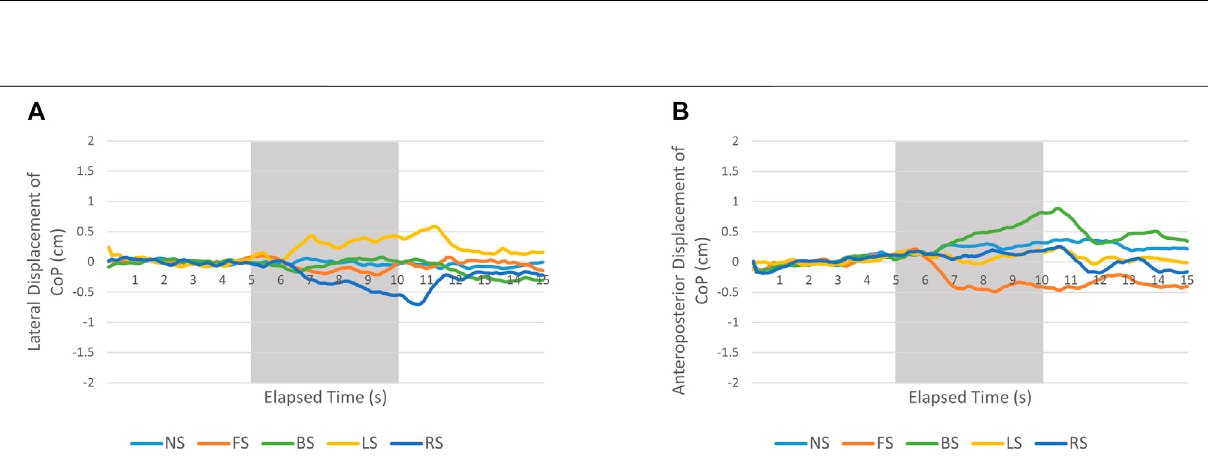
FIGURE 6 | Average of participants ’ answers on the questionnaire: (A) Result of the intensity of subjective sensation of lateral body tilt. 1 Indicates a strong sensation of leftward body tilt. 4 Indicates no sensation of lateral body tilt. 7 Indicates a strong sensation of rightward body tilt. (B) Result of the intensity of subjective sensation of anteroposterior body tilt. 1 Indicates a strong sensation of forward body tilt. 4 Indicates no sensation of anteroposterior body tilt. 7 Indicates a strong sensation of backward body tilt. (NS: No stimulation, FS: front side, BS: back side, LS: left side, or RS: right side).